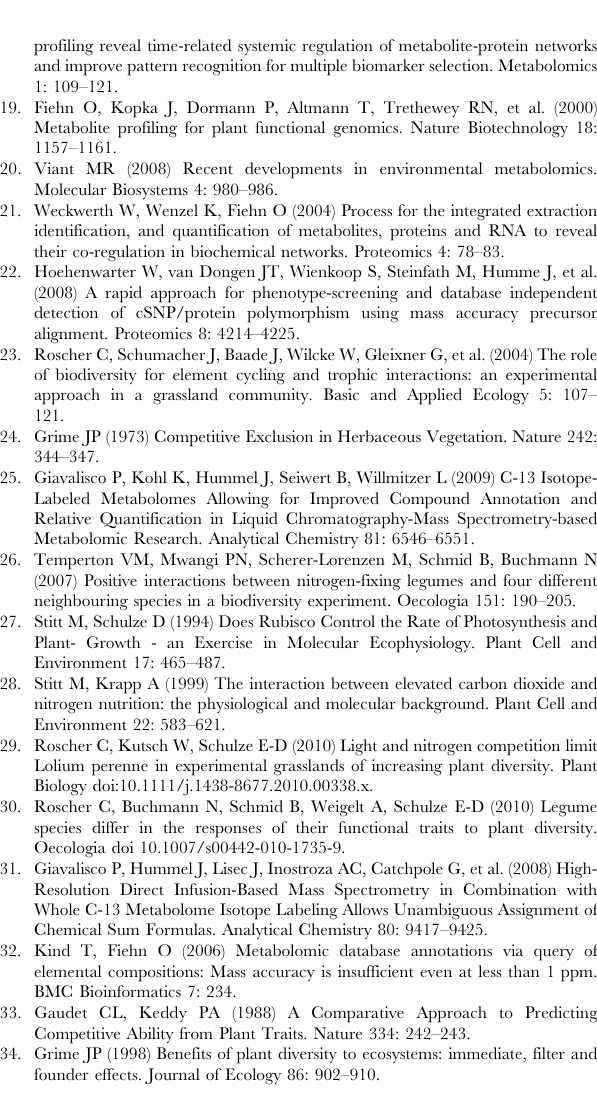
classified in community without/with legumes for non-leguminous herb species, and communities with/without non-legumes for legume species. The number of plots in which the original seed mixtures contained the studied species is given in parentheses. Figure S1 Biplots of standardized principal components analysis (PCA; first vs. second axis) based on GC-TOF-MS metabolite data analysed for (a) Medicago x varia, (b) Lotus corniculatus, (c) Knautia arvensis, (d) Bellis perennis, and (e) Leontodon autumna- lis. Labels indicate the number of species in the assemblages where species were sampled (1sp= monoculture, 2sp = 2-species mixture, 4sp = 4-species mixture, 8sp =8-species mixture, 16sp= 16-species mixture, 60sp =60-species mixture). Symbols indicate: white squares = investigated legumes grown in combination with non- legumes; black squares = investigated legumes grown in monocul- ture or in pure legume mixtures; black circles= investigated non- leguminous herbs grown in combination with legumes; white circles =investigated non-leguminous herbs grown in monoculture or in pure non-legume mixtures. Found at: doi:10.1371/journal.pone.0012569.s003 (0.04 MB TIF)